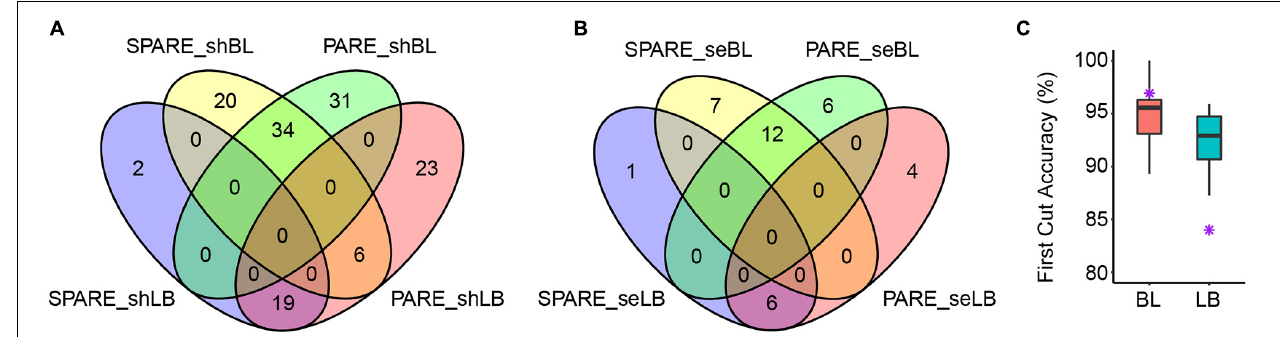
FIGURE 3 | Comparison of Parallel Amplification of RNA Ends (PARE) and Specific Parallel Amplification of RNA Ends (SPARE) results in Arabidopsis. (A) Venn diagram showing the number of short base-to-loop and short loop-to-base processed miRNAs as determined by PARE and SPARE. (B) Venn diagram showing the number of sequential base-to-loop and sequential loop-to-base processed miRNAs as determined by PARE and SPARE. shBL, short base to loop; shLB, short loop to base; seBL, sequential base to loop; seLB, sequential loop to base. (C) First cut accuracy of PARE in miRNA processing. Purple star, first-cut accuracy of SPARE (SRR6930534). LB, loop to base; BL, base to loop. Calculation of first cut accuracy was performed according to Moro et al.